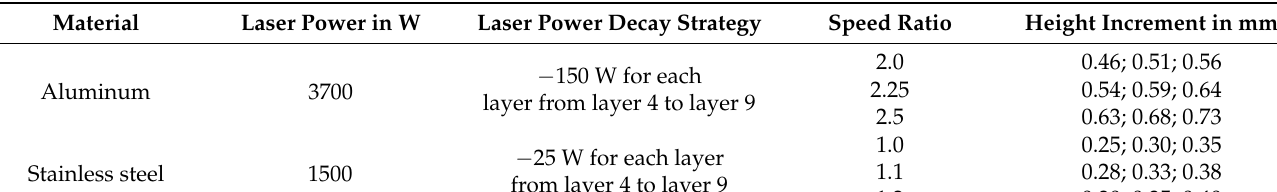
Table 4. Process parameters for the build-up of cylinders.